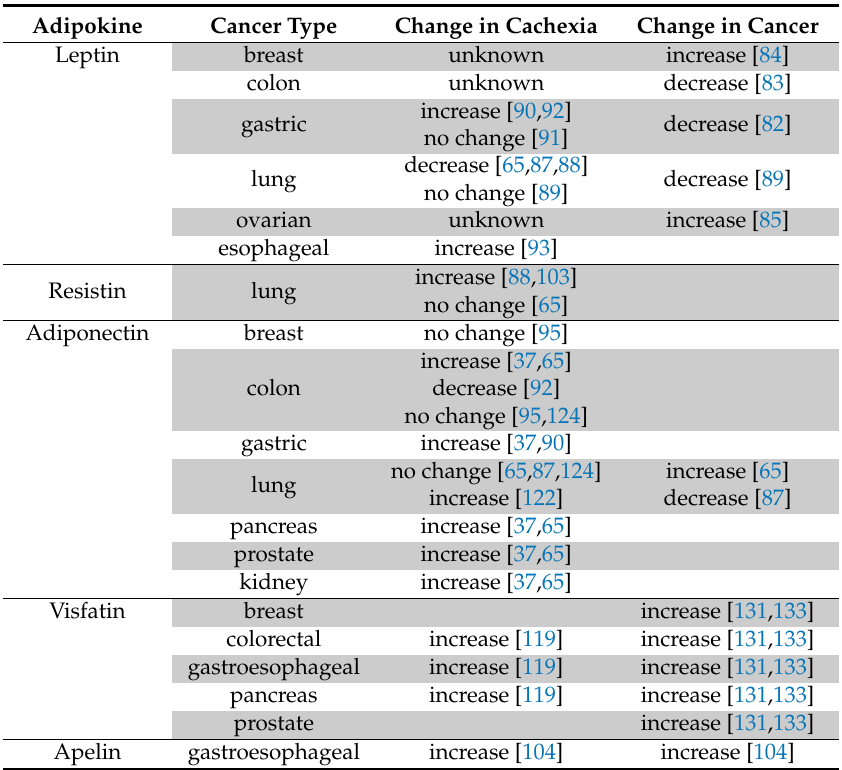
Table 1. The trend of adipokines in di ff erent cachexia-inducing tumors are shown. The table indicates cancer type and the decrease / increase of adipokines in cachectic conditions (change in cachexia) and in non-cachectic conditions (change in cancer). The relative references are reported in the